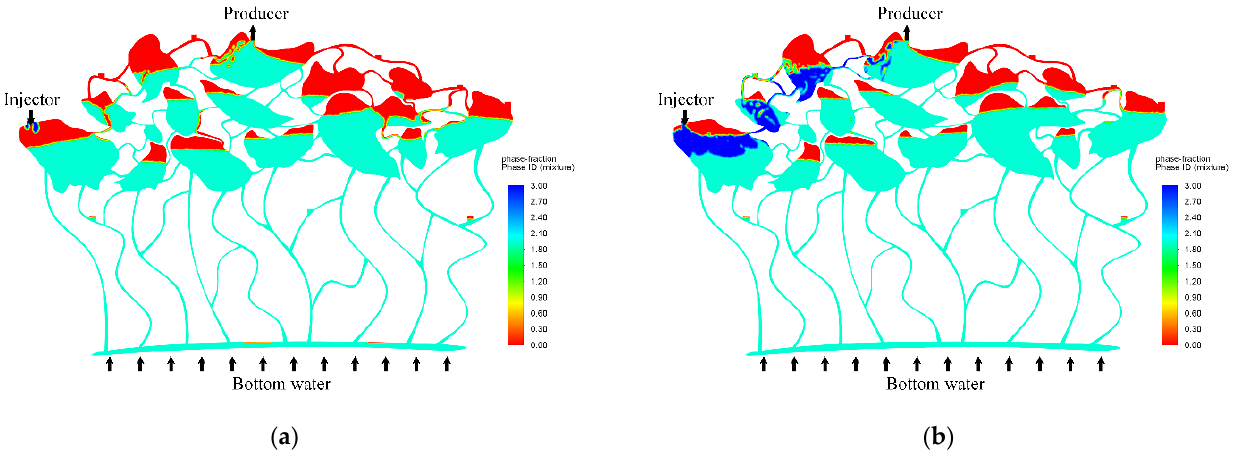
Figure 7. Fluid distribution in different displacement stages of water injection: ( a ) initial stage; ( b ) last stage. It can be observed that the injected water in the middle and lower parts of the model migrated downwards under the action of gravity, and the lateral movement also occurred under the resistance of the bottom water. In this process, the remaining oil flowed together with water to the production well, the injected water wave expanded to other fracture– cavity structure (Figure 7 right, dark blue zone), and an oil–water interface, distributed along the connection line of injection and production wells, was gradually formed [9].